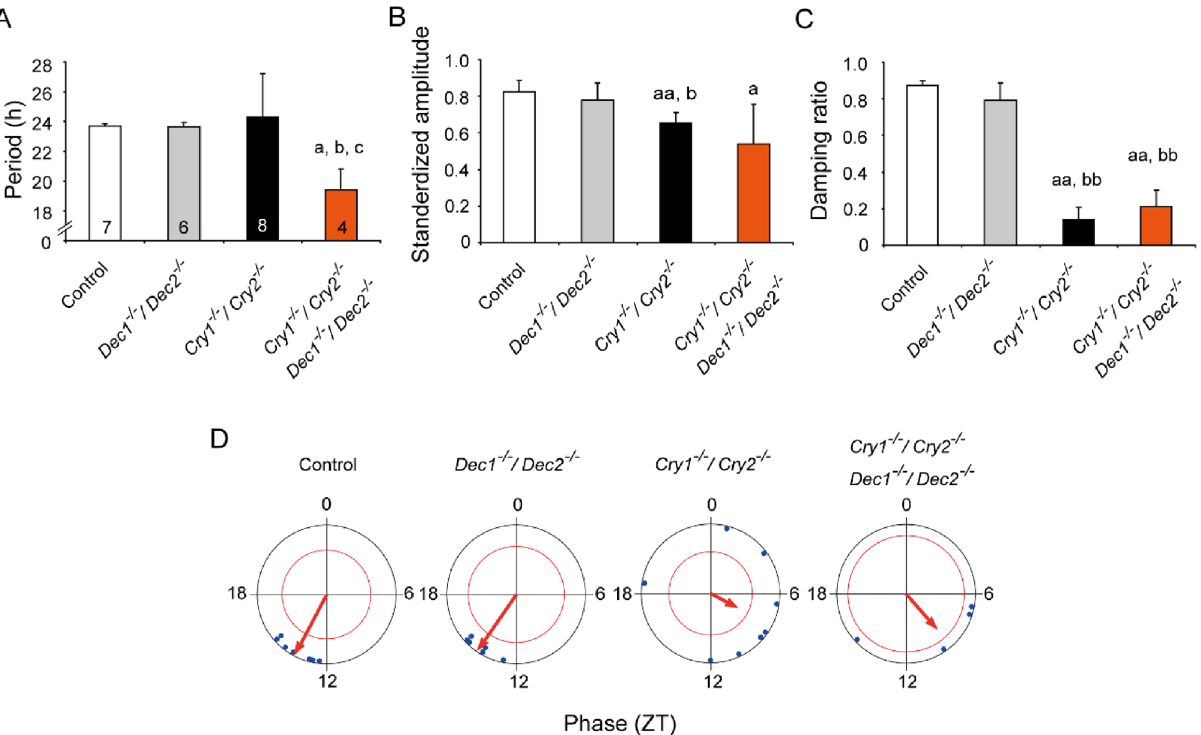
Figure 4. Rhythm properties of neonatal SCN in culture from the control, Dec1/Dec2 deficient, Cry1/Cry2 deficient, and Cry1/Cry2/ Dec1/Dec2 quadruple-KO mice. ( A ) Mean periods of PER2::LUC rhythms with standard deviations (SD) calculated by periodogram are shown as columns and vertical lines. A number in each column indicates the number of SCN examined. ( B ) Standardized amplitude of PER2::LUC rhythms are expressed in bar graph (mean ± SD). ( C ) Damping ratio of PER2::LUC rhythms is also shown in a bar graph (mean ± SD). Statistical comparisons, a; P < 0.05, aa; P < 0.01 vs. control, b; P < 0.05, bb; P < 0.01 vs. Dec1/Dec2 deficient mice, c; P < 0.05 vs. Cry1/Cry2 deficient mice (one-way ANOVA with a post hock Tukey–Kramer test or Kruskal–Wallis with a post-hoc Steel-test). ( D ) Peak phase of PER2::LUC rhythms on the 1st day of culture in ZT is illustrated as Rayleigh plot, where ZT 0 indicates the time of light-on in the light–dark cycles. Blue dots indicate the peak phases of individual rhythms. Red arrow in each circle indicates the mean circadian phase of each genotype. A red circle is 95% confidence level. If an arrow extends over the red circle, the distribution of peak phases is regarded as significantly consolidated. Data of the control and Cry1/Cry2 -deficient SCN are same as in Fig.